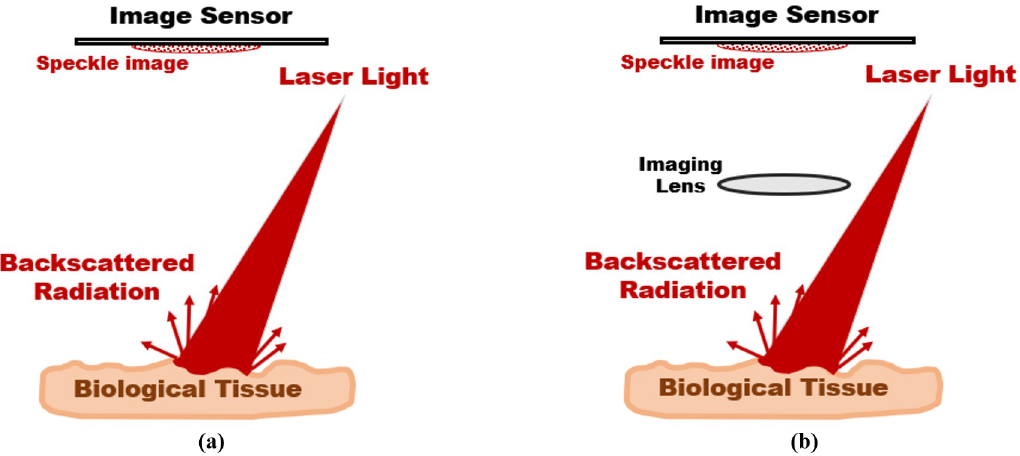
Fig 2. Two-basic biospeckle imaging configurations for collecting biospeckle images of a biological tissue surface: (a) objective speckle and (b) subjective speckle.